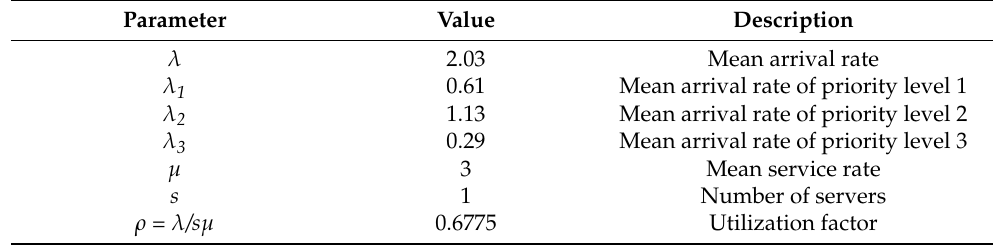
Table 5. Definition of parameters for the performance